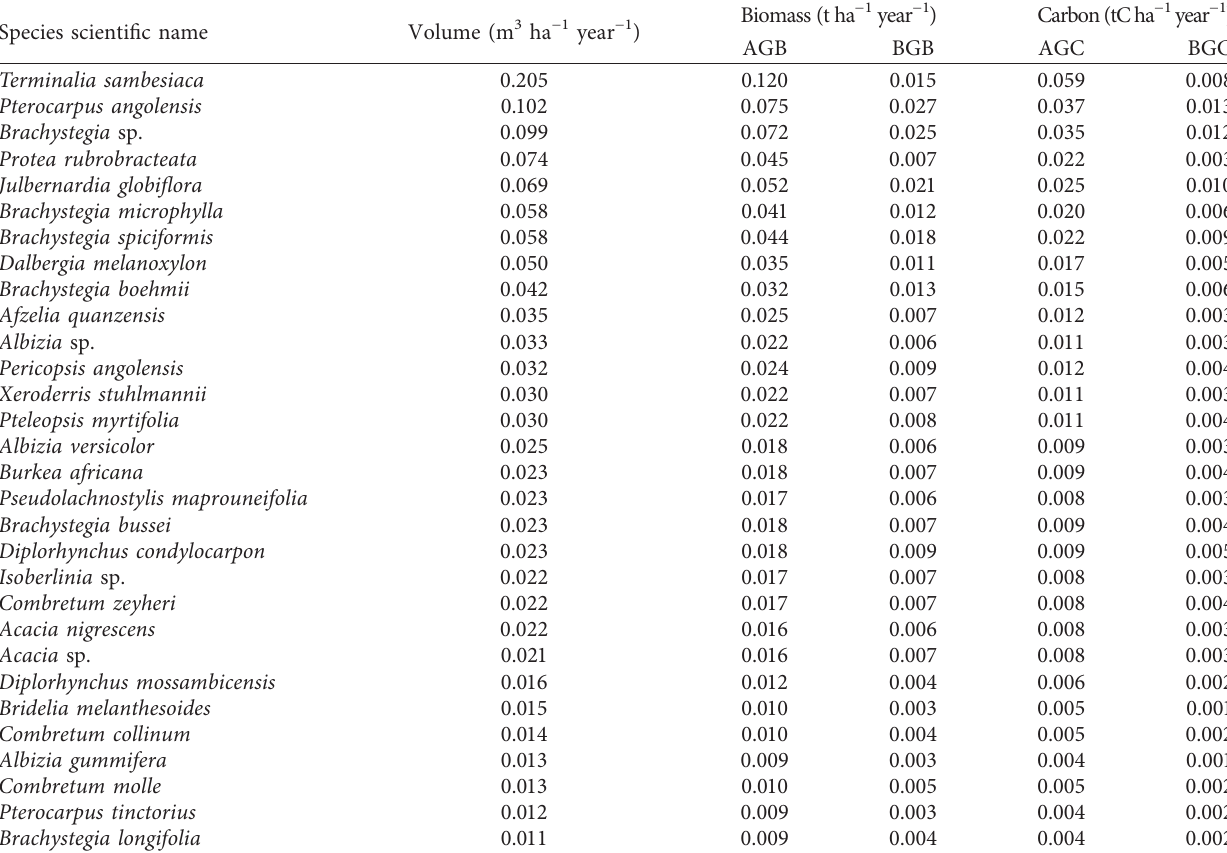
Table 5: Thirty species with highest volume, biomass, and carbon removals in Miombo woodlands in Mainland Tanzania. Species scientific